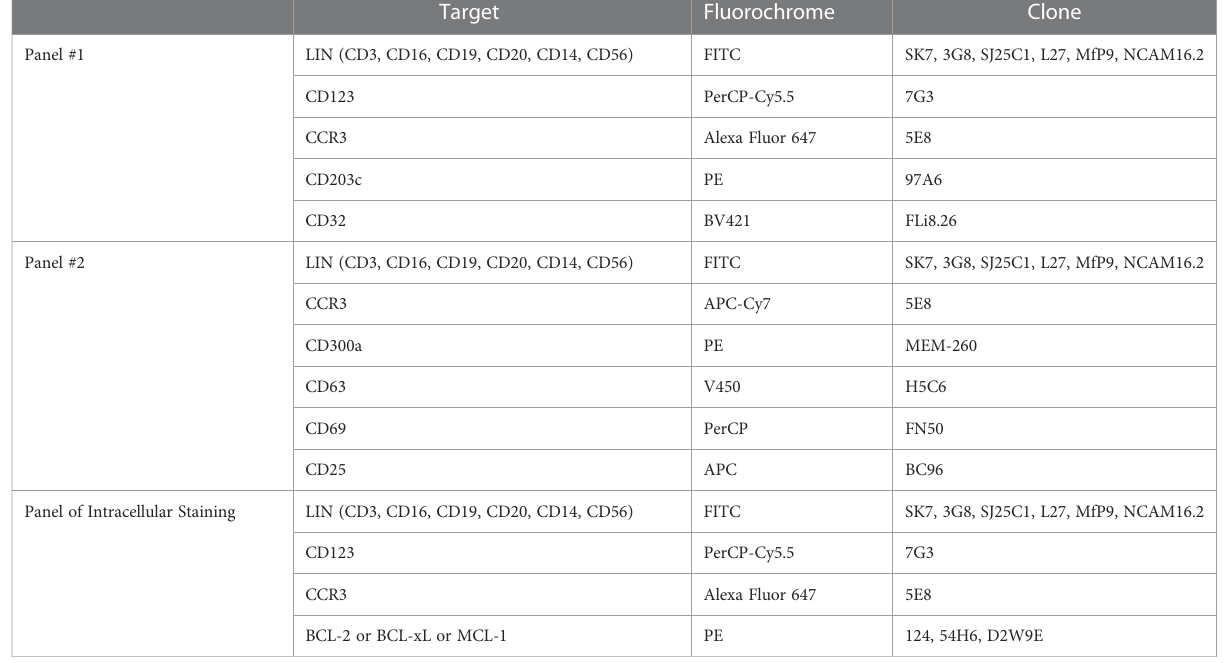
TABLE 1 Panels for fl ow cytometric analysis of blood